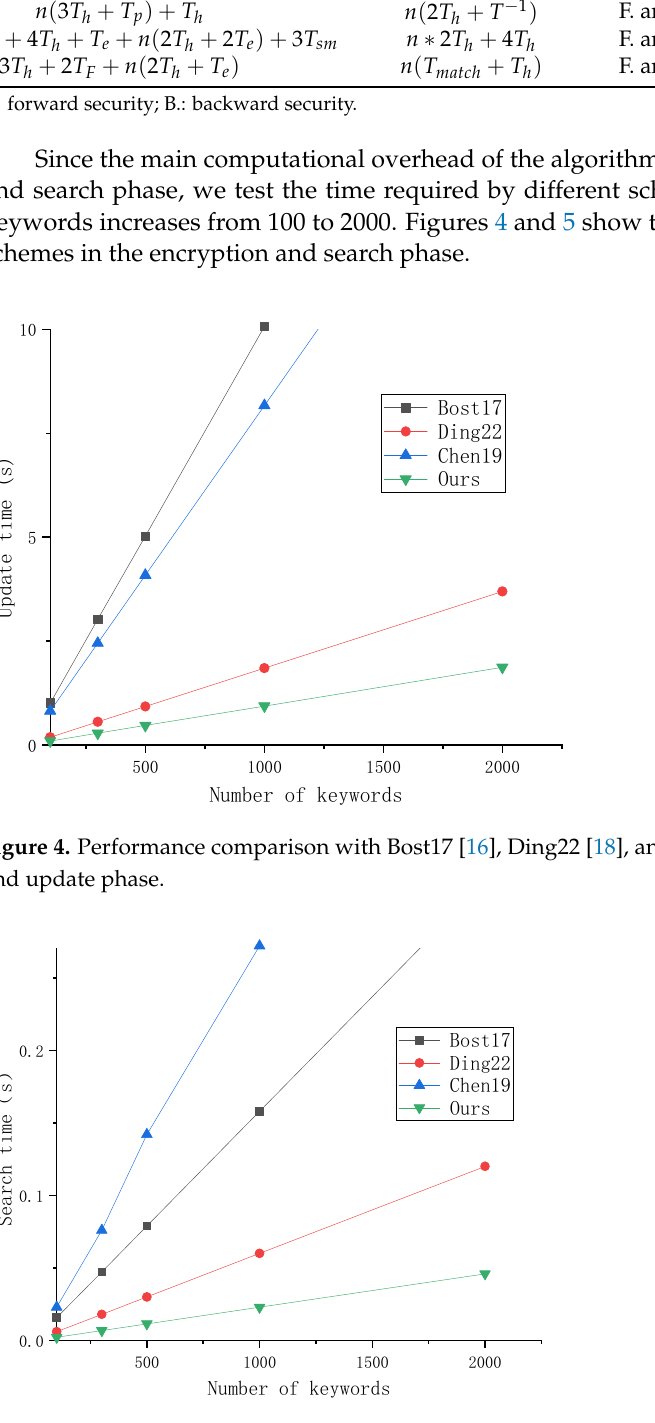
Figure 5. Performance comparison with Bost17 [16], Ding22 [18], and Chen19 [9] in the search phase.